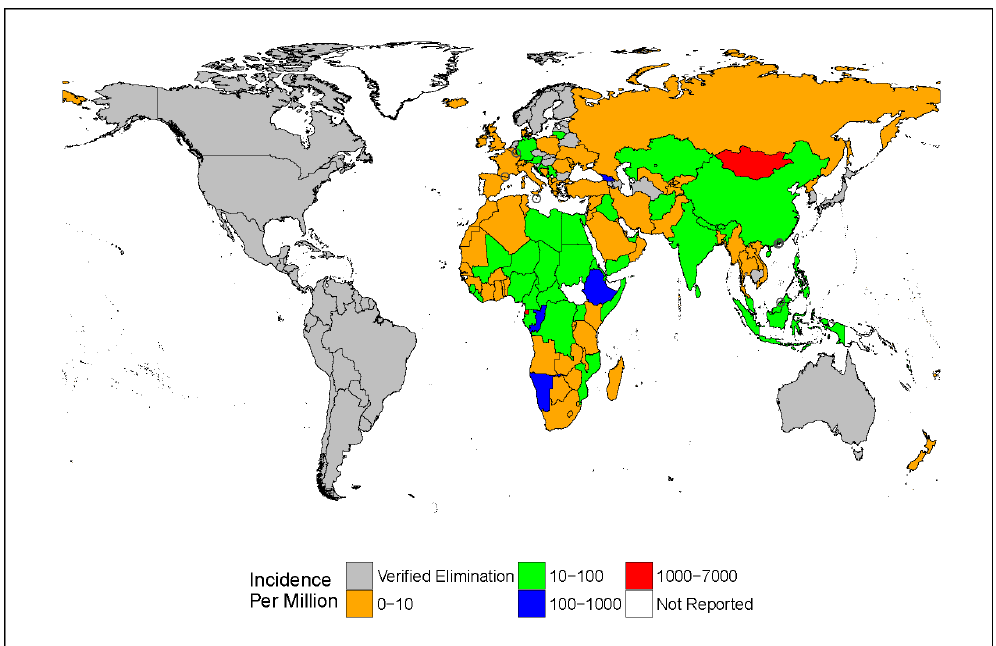
Figure 1. Current measles incidence and countries with verified elimination. Depiction of 2015 per-country measles incidence per million population, overlaid with countries for which measles elimination has been officially verified (grey) [53–56]. Grey circles indicate countries not readily viewable on the map. Verified elimination was obtained from documentation produced by the World Health Organization (WHO) regional elimination verification commissions [53–55]. Shapefile was obtained from NaturalEarth.com, 10-meter resolution, version 3.1.0, and was produced in R version 3.2.3.